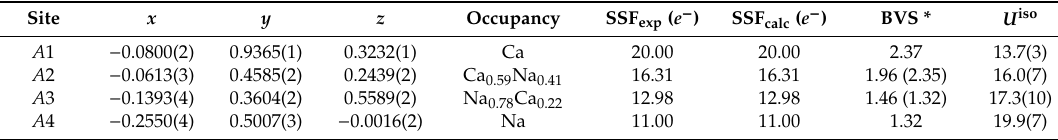
Atomic coordinates, occupancies, bond valence sums, experimental and calculated site-scattering factors (SSF exp and SSF calc , respectively), and equivalent isotropic displacement parameters (Å 2 × 10 − 3 ) of